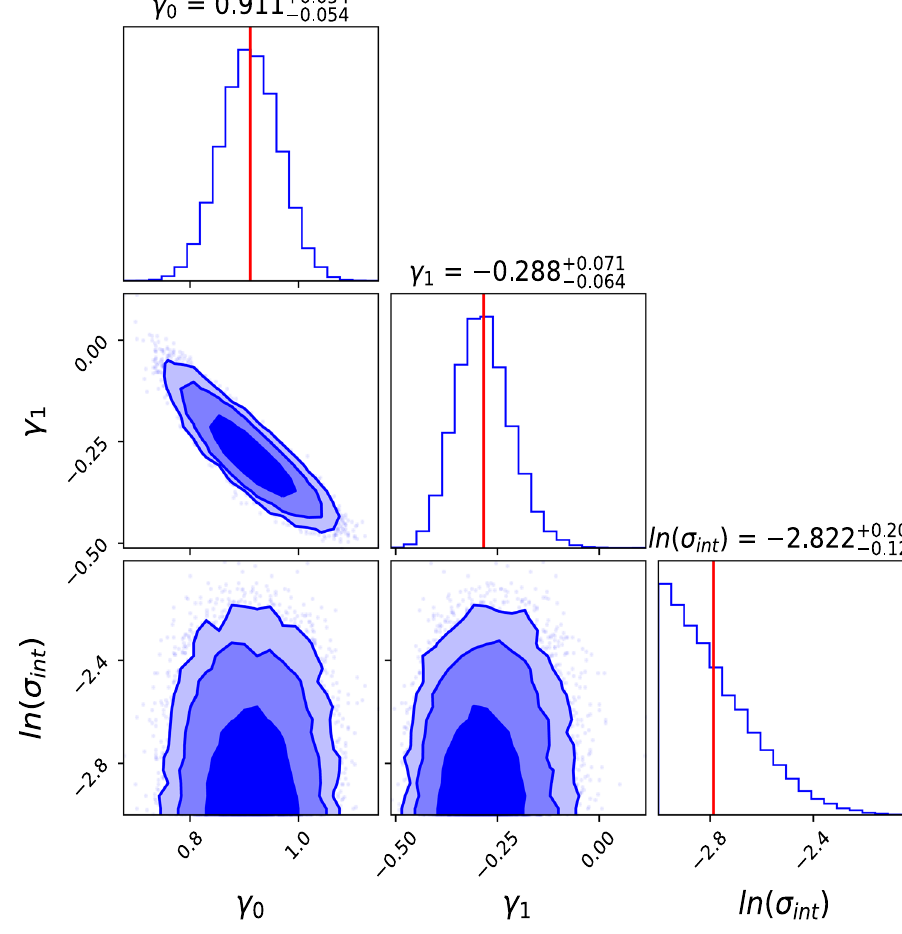
Fig. 5 For SPT-SZ dataset: constraints on the parameters γ 0 and γ 1 along with ln (σ int ) , defined in Eq. (8). The plots along the diagonal are the one-dimensional marginalized likelihood distributions. The contour plots represents the two-dimensional marginalized constraints showing the 68%, 95%, and 99% credible regions. These contours have been obtained using the Corner python module